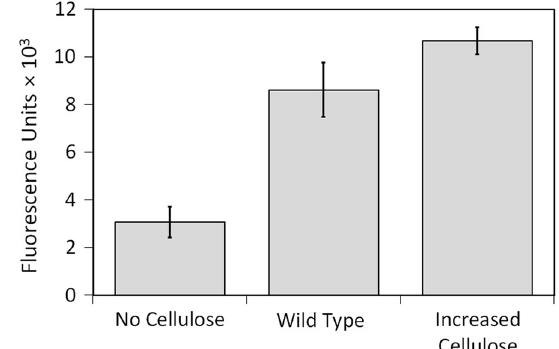
Fig. 3 Fluorescence intensity assay with calco fl uor binding to EPS extracted from bio fi lms of the different cellulose expression variants (excitation and emission at 355 and 434 nm,